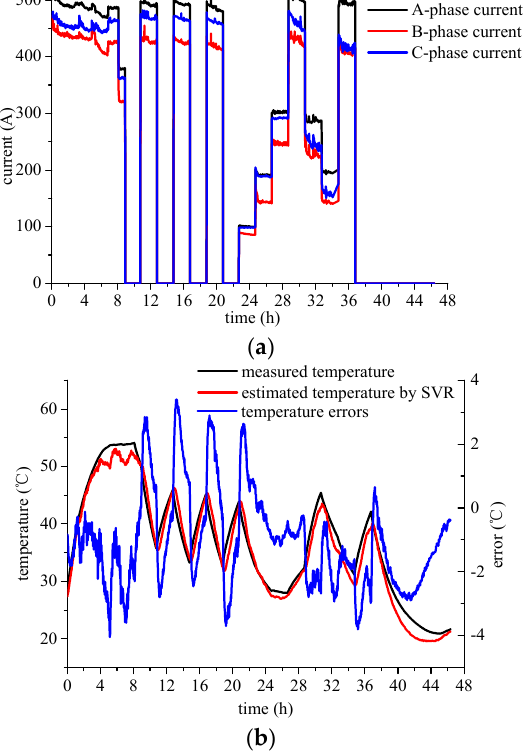
Figure 12. The measured results and estimated temperature based on SVR. ( a ) Current; ( b ) Temperatures inside the three-core cable joint.